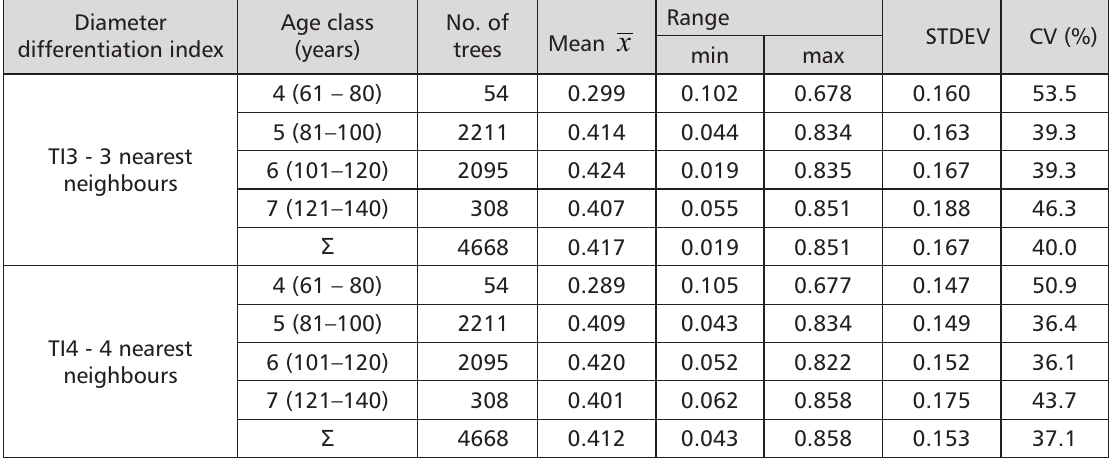
The DBH differentiation index values by the 20-year age classes